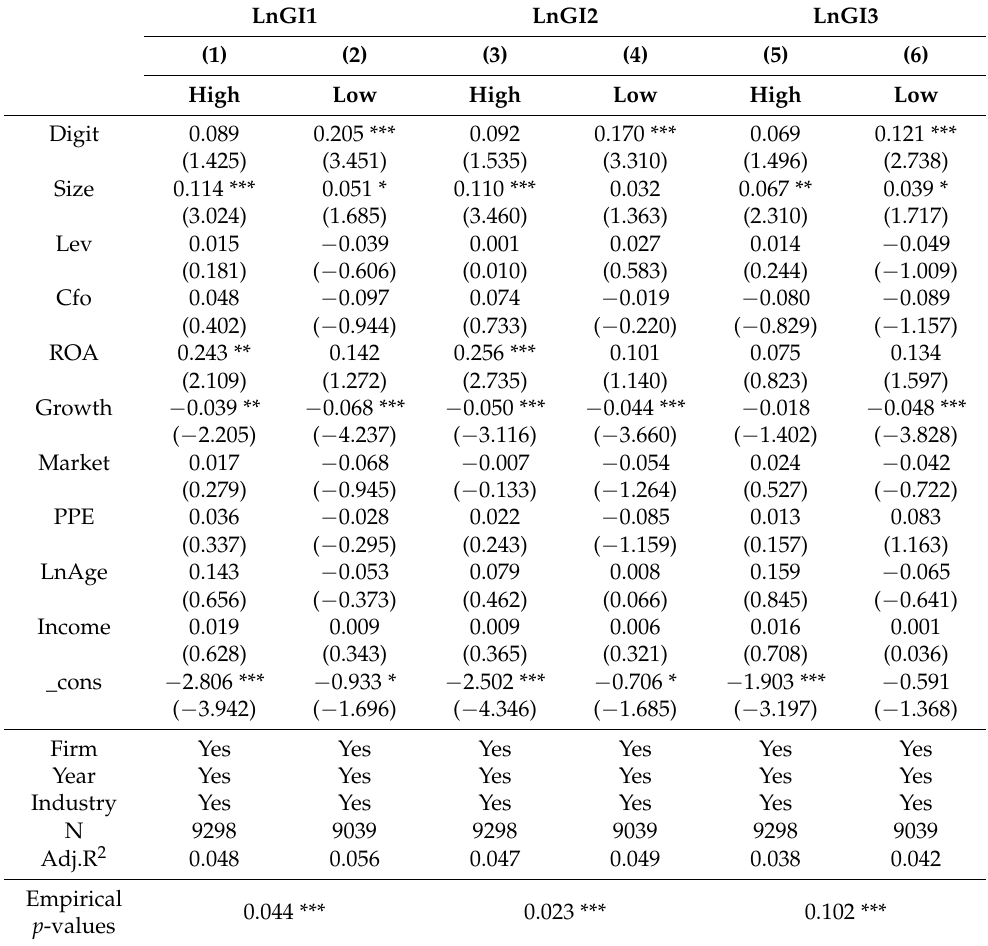
Table 8. Heterogeneity test for regional digital environment.